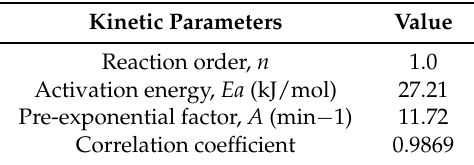
Table 4. Kinetic parameters of the degradation of fructose with the CePW 12 O 40